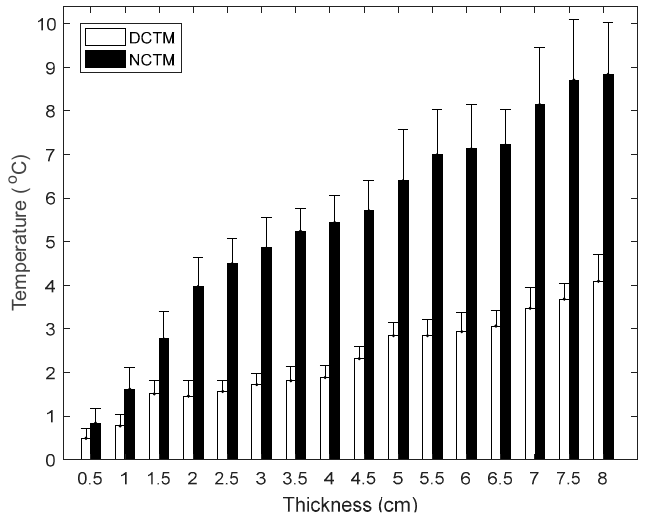
Figure 6. Averaged temperature differences (using one-hour sitting test data) between DCTM and NCTM for low/intermediate density foams regarding different thickness. Error bars denote ± 1 standard deviation.